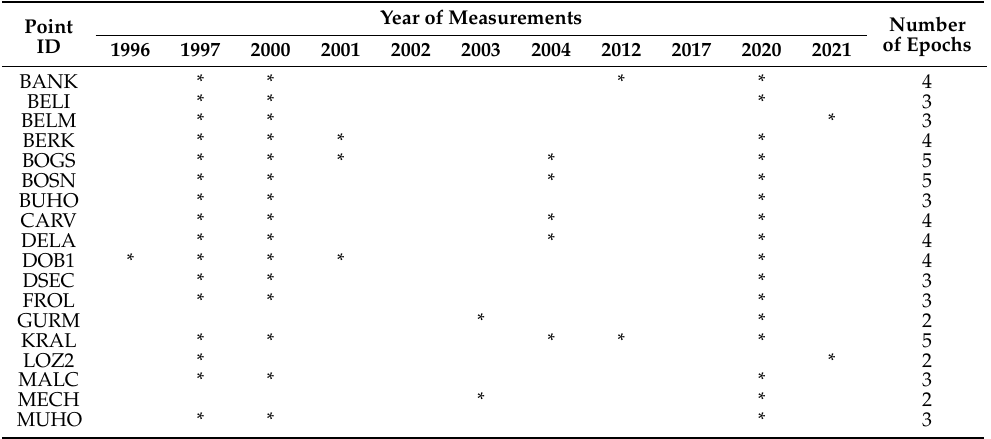
Table 1. Major models and parameters used in GAMIT GPS data processing. Elevation cutoff angle and data weighting 10 ◦ , data weighting depending on the elevation angle Data sampling and data weighting 30 s for data editing, and 120 s for parameter estimation Antenna phase left IGS ANTEX files are used to correct absolute PCVs of satellite and receiver Ionospheric refraction Ionosphere-free linear combination VMF1 for dry delay and parameter estimation in 2-h intervals for wet delays. Troposphere refraction Troposphere horizontal gradients in 24-h interval are estimated. Ocean tide Solid Earth tide, pole tide Models recommended by IERS Conventions 2010 Table 2. Epochs of GPS measurements. The asterisk indicates the presence of measurements. Point